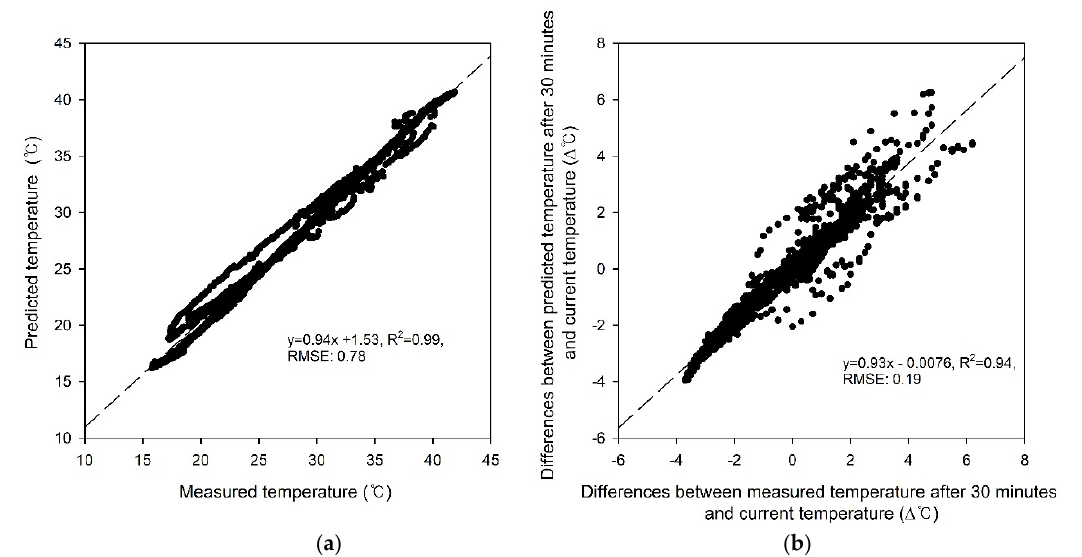
Figure 7. Comparisons between ( a ) predicted and measured temperature and ( b ) difference between the current temperature and predicted or measured temperature after 30 min.